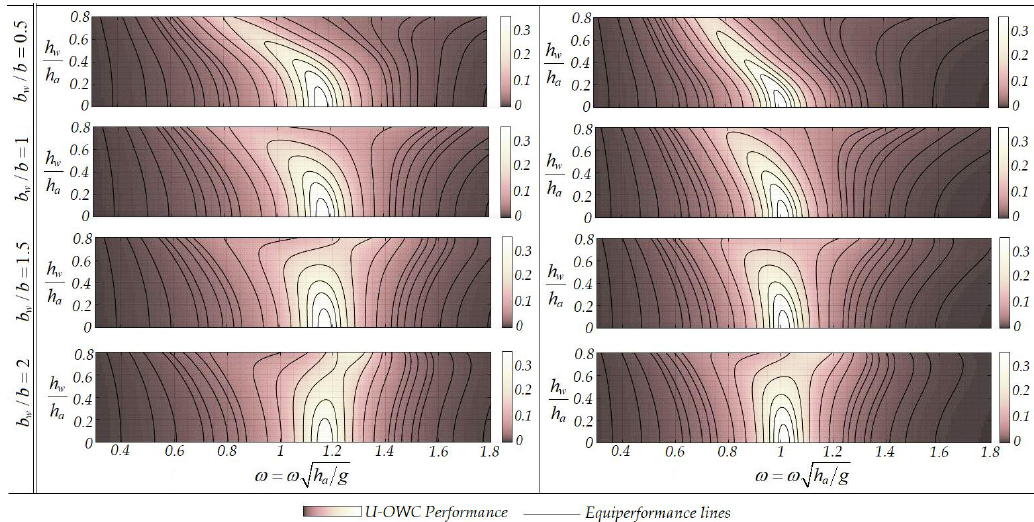
Figure 8. Contour plots of U-type OWC performance in uniform bathymetry for di ff erent values of the front wall’s draft D w / h = 0.5 ( left column ) and D w / h = 0.7 ( right column ), and di ff erent values of the duct section ( b w / b ) and the front wall height ( h w / h ) . ( Parameters : h a = h b = 10 m , b = 3 m , h c = 7 m , d w = d = 0.5 m , (cid:101) λ = 1.4 ) .